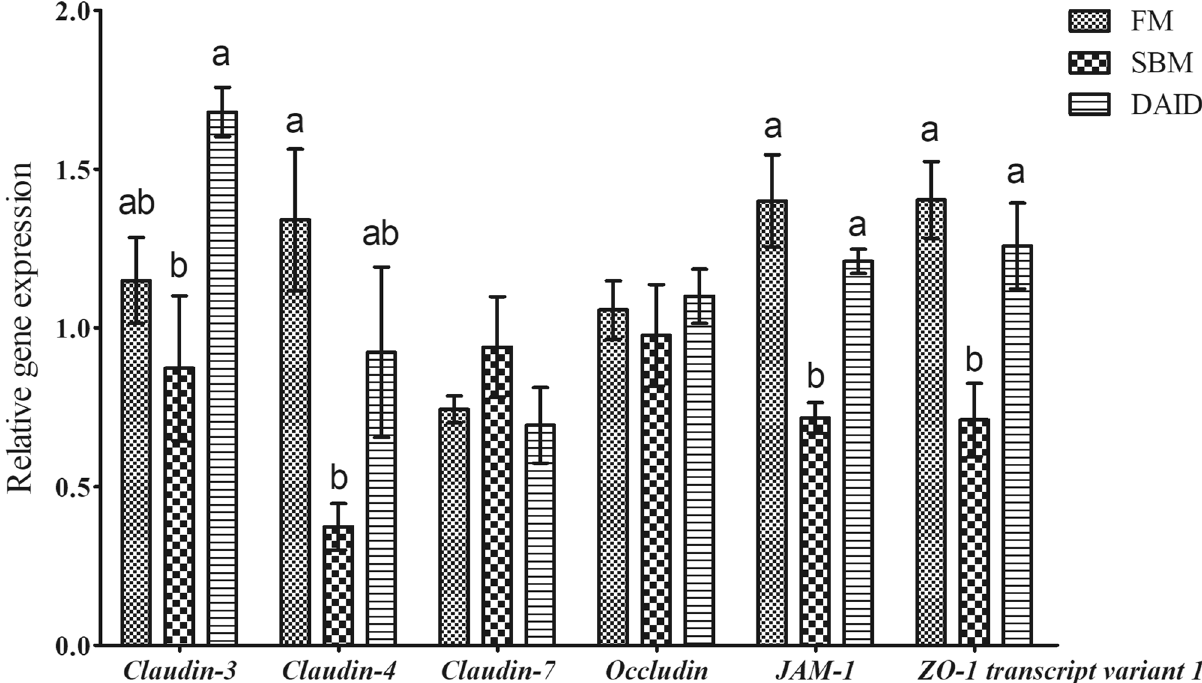
Figure 4. Effects of daidzein on gene expression of tight junction proteins of turbot fed with soybean meal. FM fish meal diet, SBM soybean meal diet, DAID 40 mg/kg daidzein included into SBM diet, JAM-1 Junctional adhesion molecules-1, ZO-1 Zonula occludens-1. Values are mean ± SEM, n = 3 and values shared different letters are significantly different ( P < 0.05).